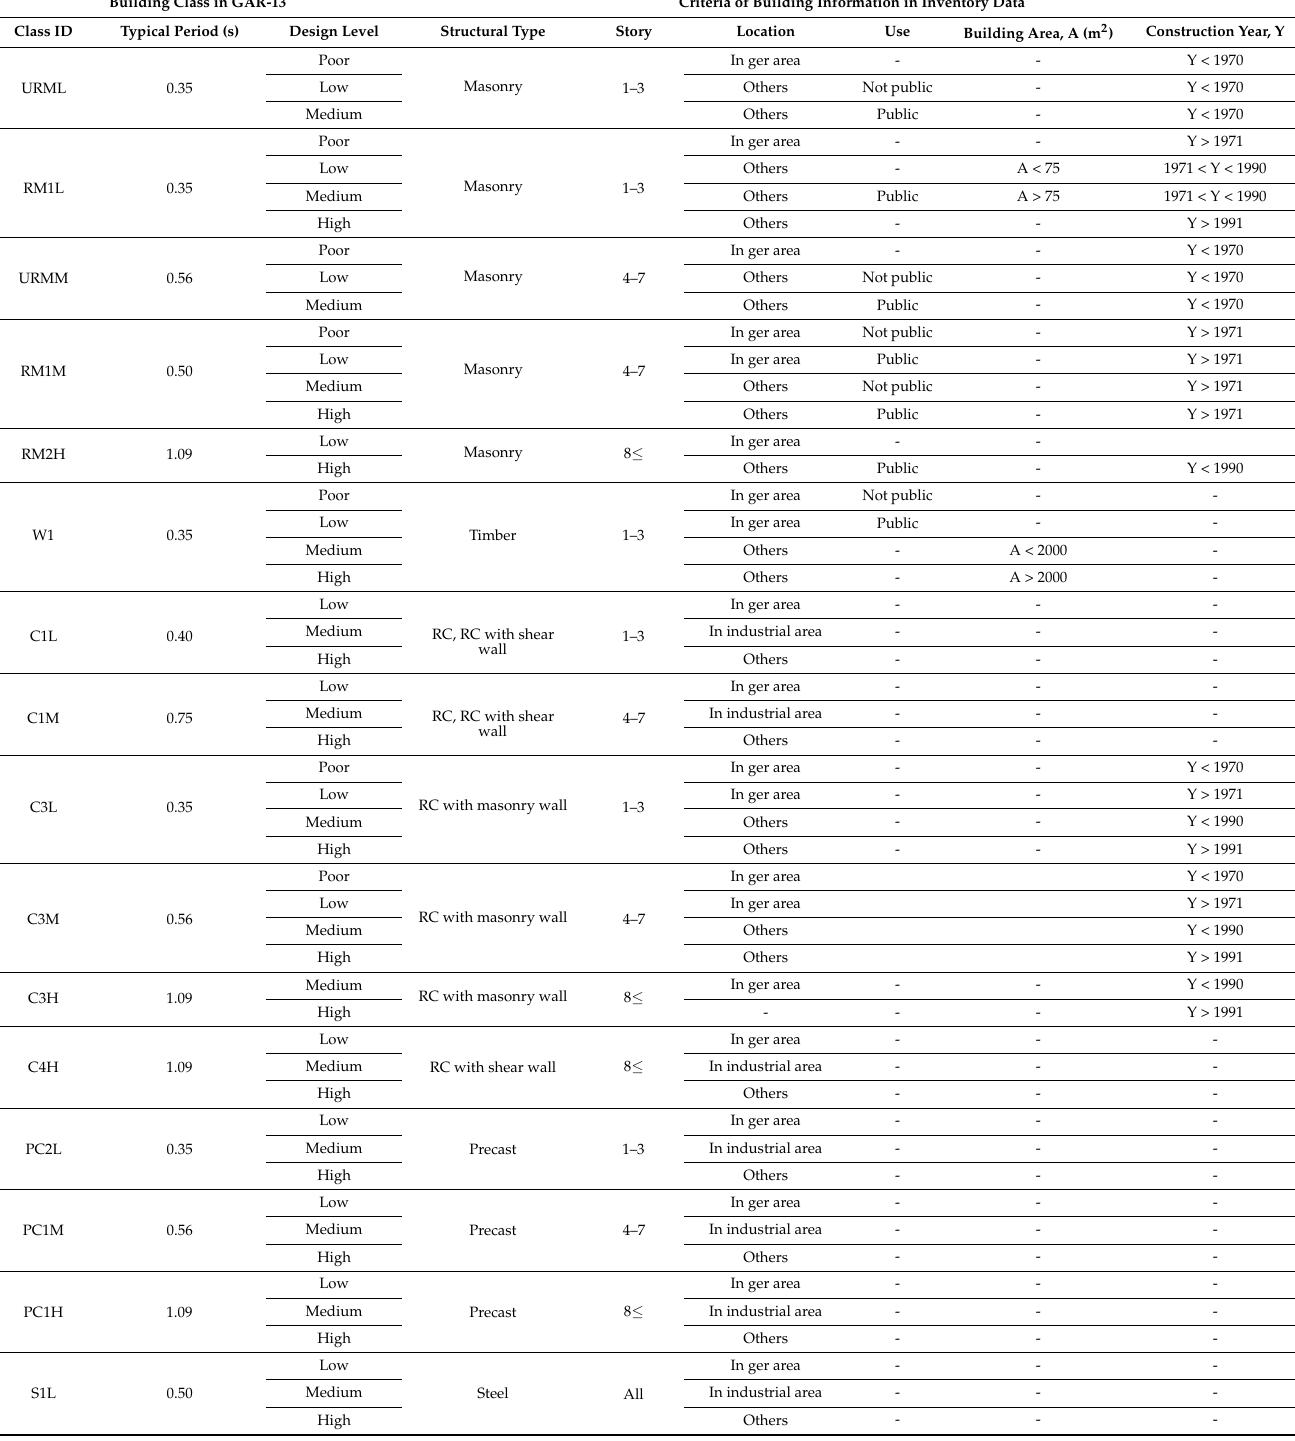
Table 8. Building classes of GAR-13 and criteria of building information in the inventory data.